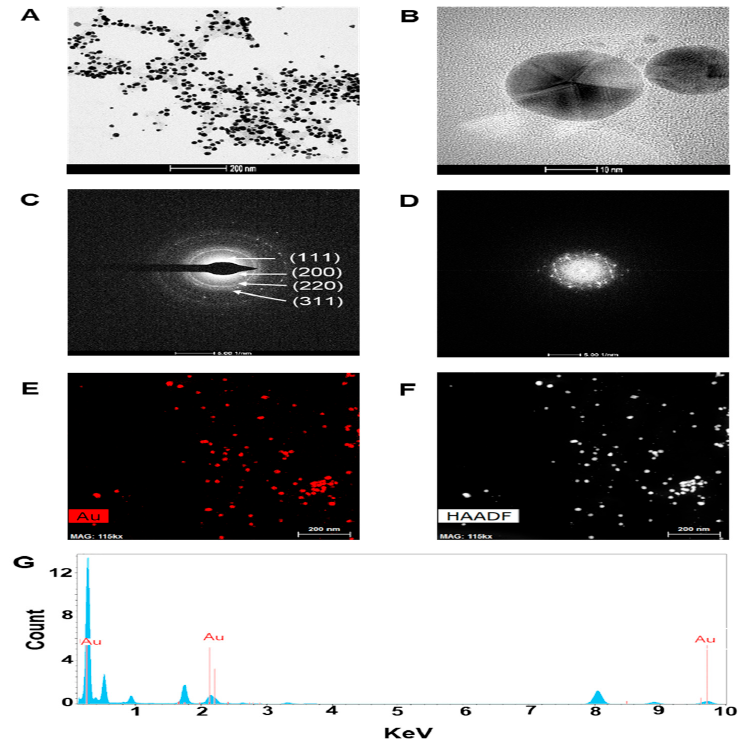
Figure 1. Characterization of Cudrania tricuspidata root (CTR)-gold nanoparticles (GNPs). High resolution transmission electron microscopy (HR-TEM) images at ( A ) low magnification (scale bar, 200 nm), ( B ) high magnification (scale bar, 10 nm), ( C ) selected area electron di ff raction (SAED) pattern, ( D ) fast Fourier transform (FFT) pattern ( E,F ) high-angle annular dark field (HAADF) image, and ( G ) energy dispersive spectroscopy (EDS) analysis of